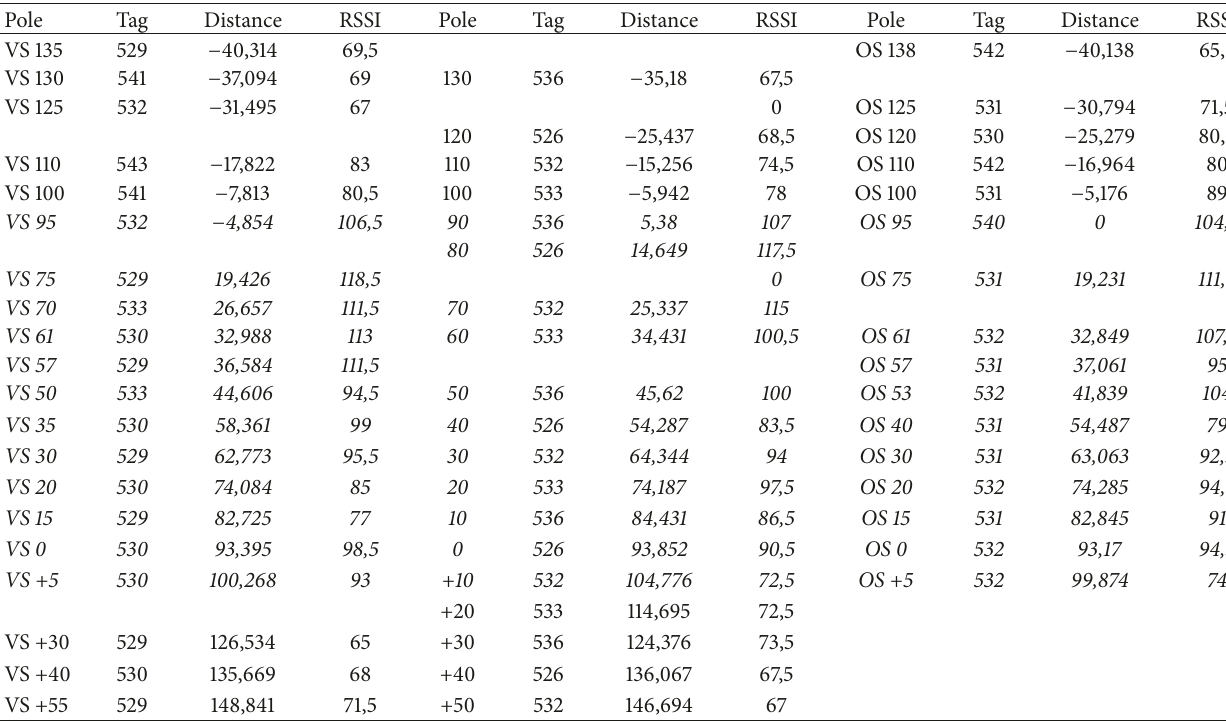
Table 1: Compiled table of antenna 1